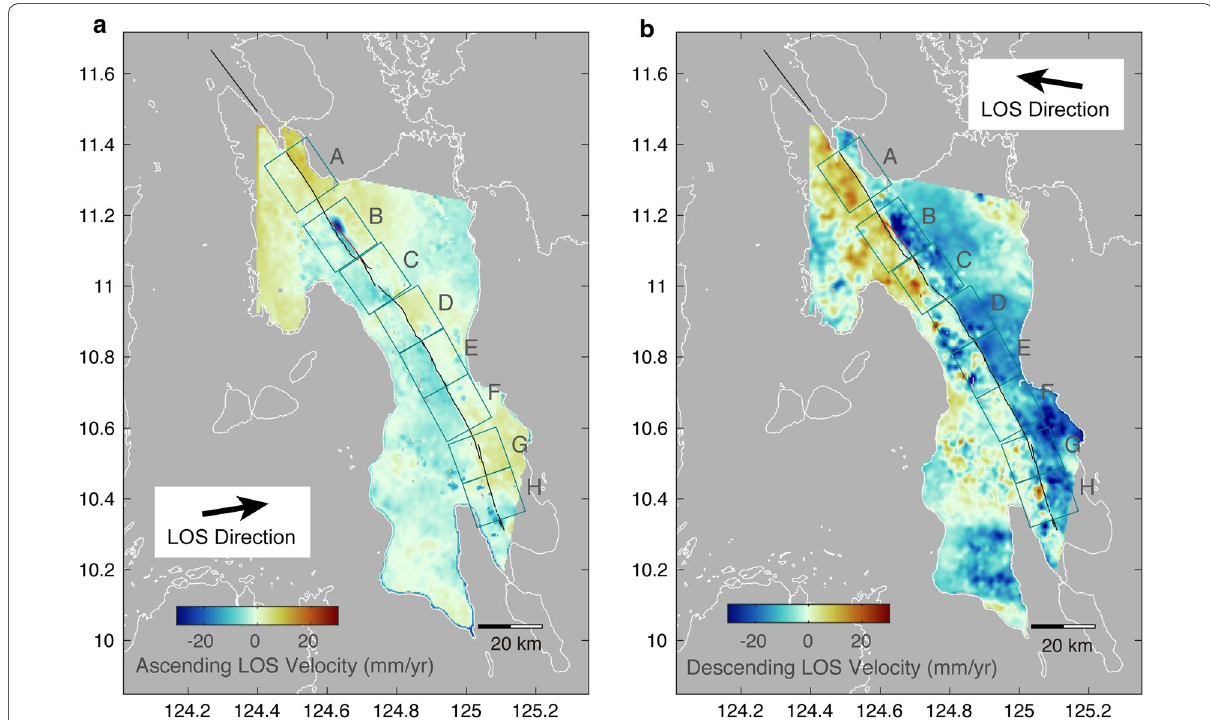
Fig. 5 Mean velocity in the LOS directions, obtained from the ascending data ( a ) and descending data ( b ). Positive and negative values indicate displacements toward and away from the satellite,